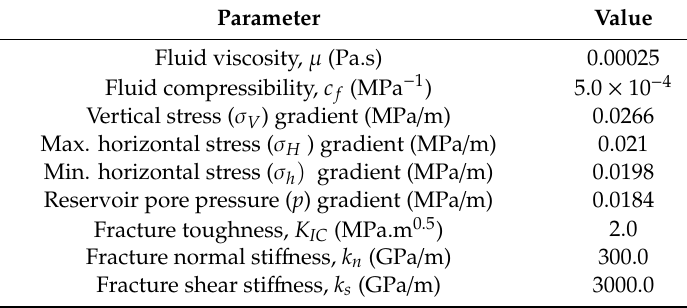
Table 2. Rock mechanical properties and in-situ